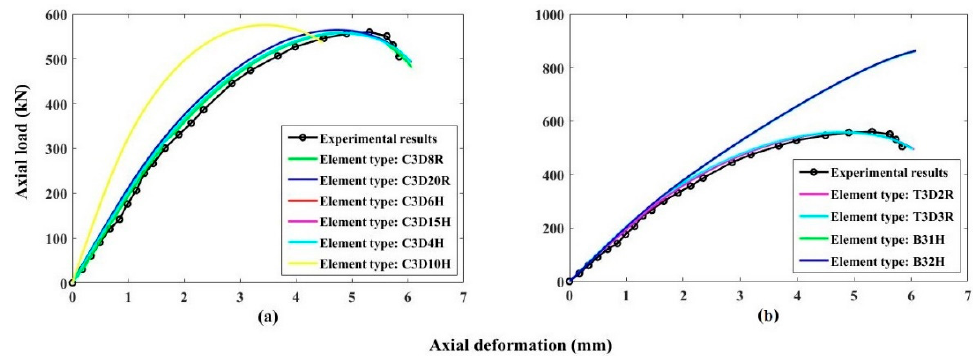
Figure 9. Sensitivity of various element types on load-deflection behavior of control specimen ( a ) concrete elements ( b ) FRP bars elements.